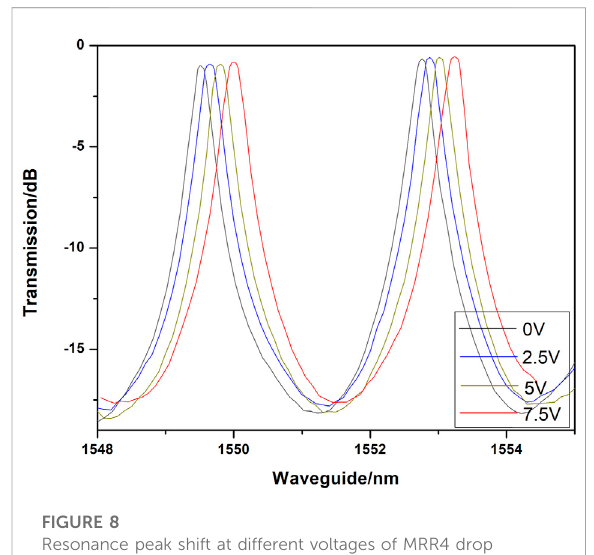
FIGURE 9 Transmission spectrafrom 8 output channels of the crosstalk of AWG with